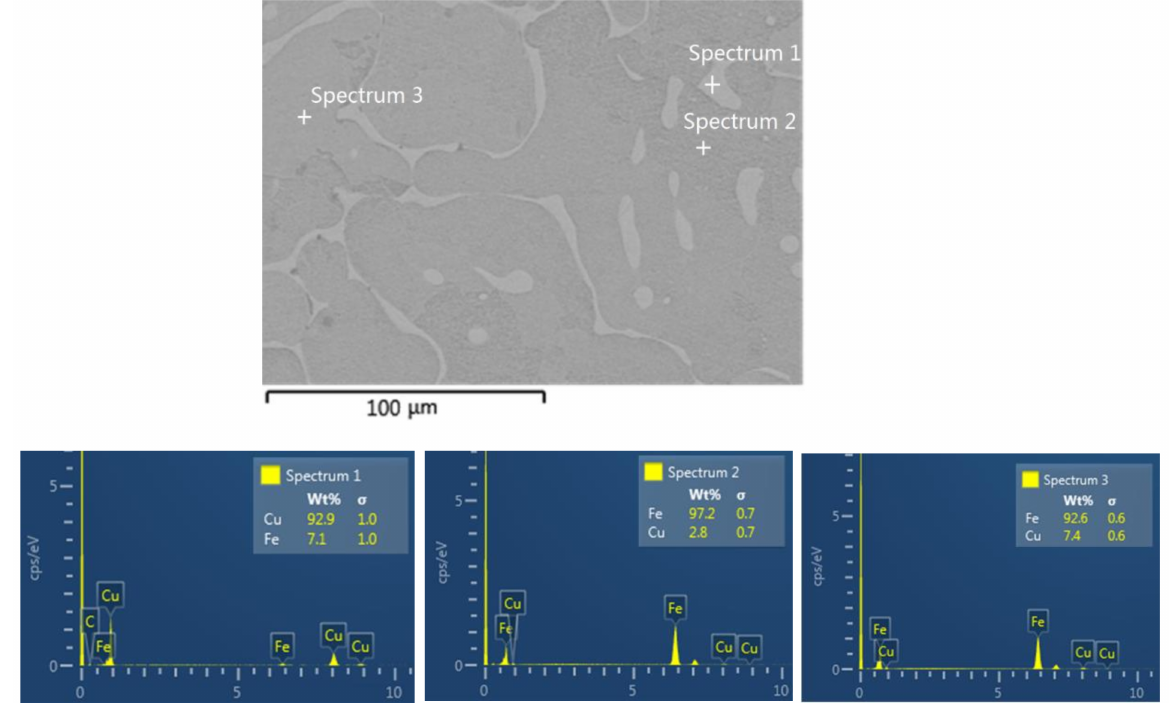
Figure 2. SEM (scanning electron microscope) image and EDS (energy dispersive X-ray spectroscopy) results of steel